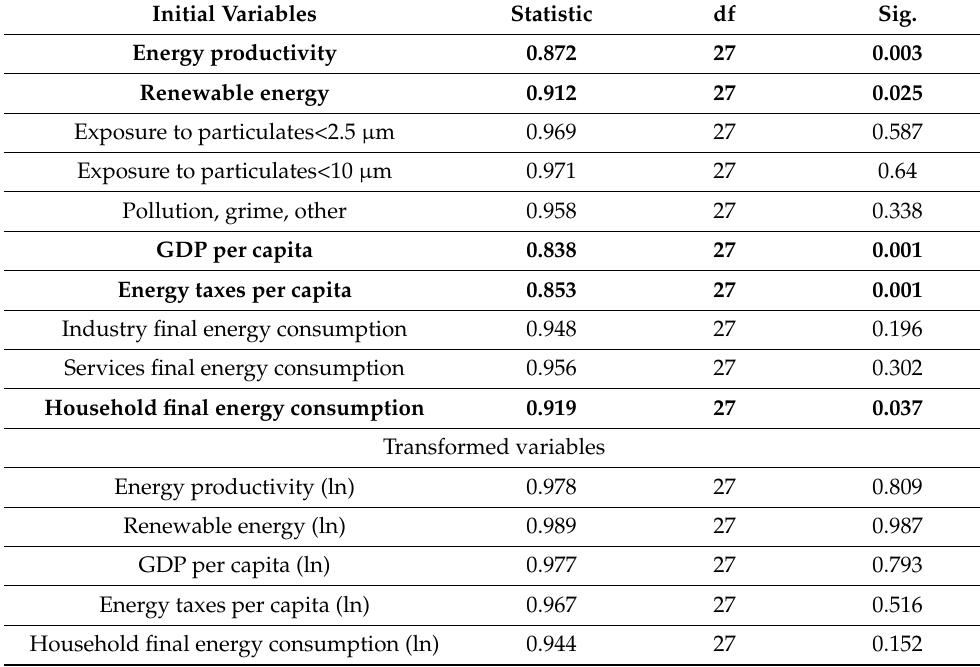
Table 2. Results of the Shapiro–Wilk test. Initial